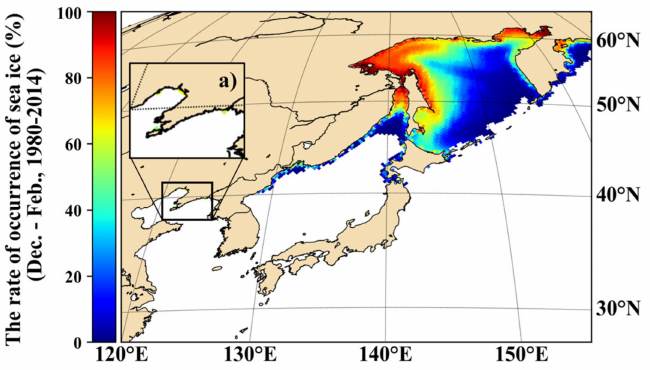
Figure 3. Statistical map of spatial occurrence rate of sea ice using long-term satellite-based sea-ice data (EASE-Grid 2.0 Weekly snow cover and Sea-ice Products of NSIDC) for research areas expanded from 1980 to 2014; ( a ) distribution of sea ice occurrence in the Bohai